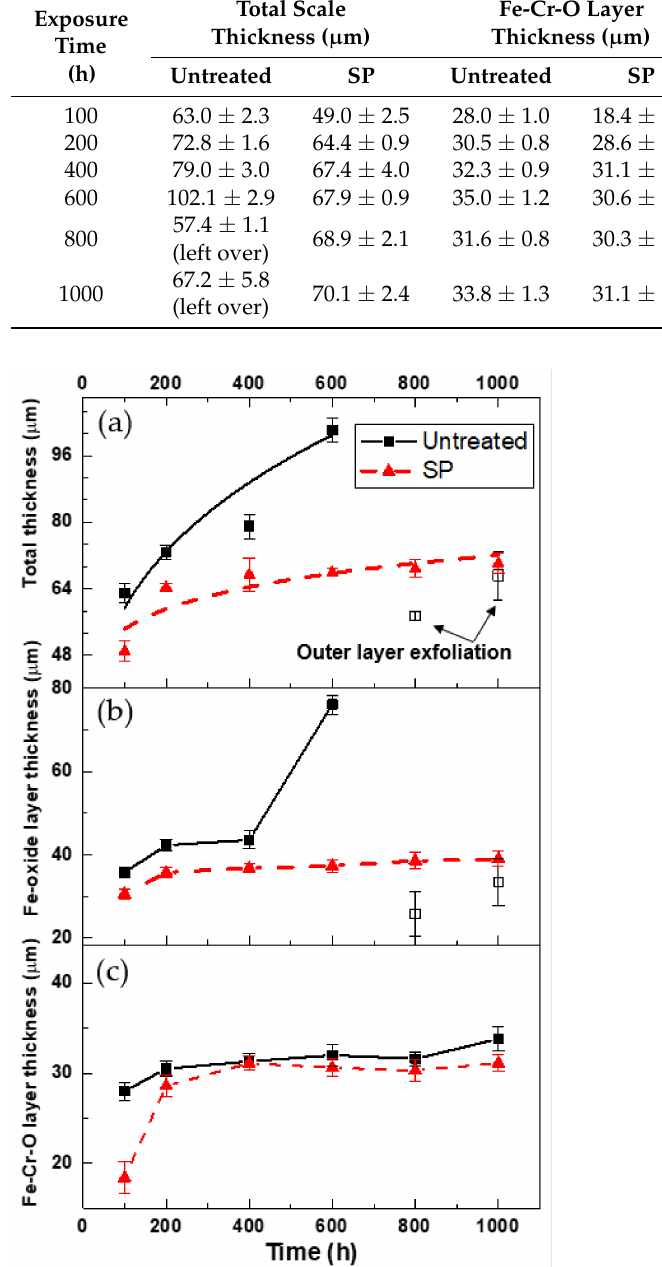
Figure 6. Oxidation scale thickness as a function of exposure time: ( a ) total layer, ( b ) outer Fe-oxide (Fe 2 O 3 and Fe 3 O 4 ) layer, and ( c ) inner (Fe-Cr-O spinel)